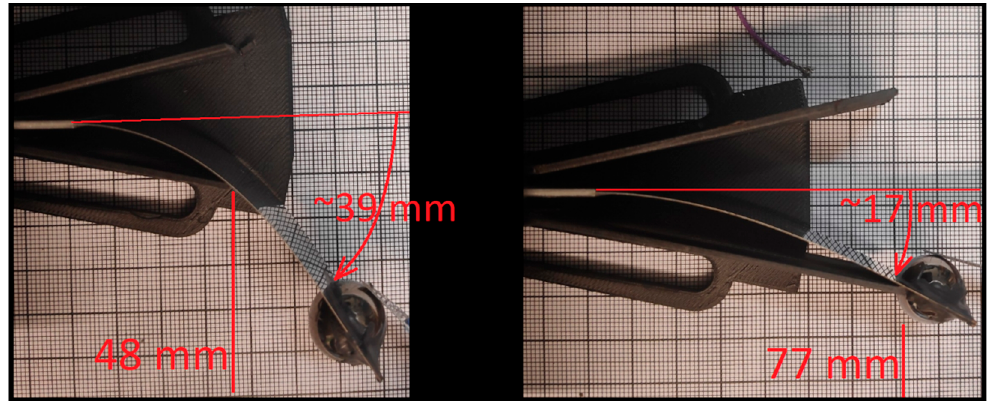
Figure 6. Tip mass movement with different limiter.